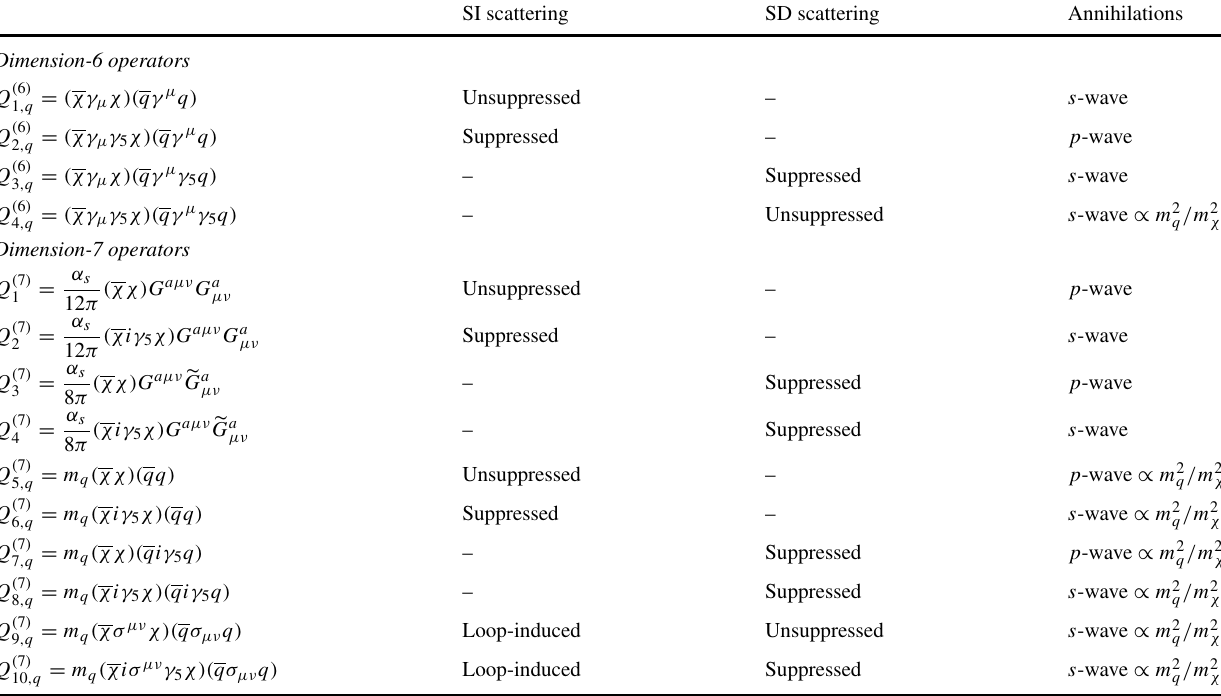
Table 2 A full list of dimension-6 and 7 operators included in this study, and the types of interactions they induce. For the DM-nucleon scattering cross-section, we distinguish between spin-independent (SI) and spin-dependent (SD) interactions, with the former receiving a large coherent enhancement and the lattervanishing for nuclei with zero spin. We use “unsuppressed” (“suppressed”) to denote tree-level contribu- tions that do not vanish (that vanish) in the zero-velocity limit, while